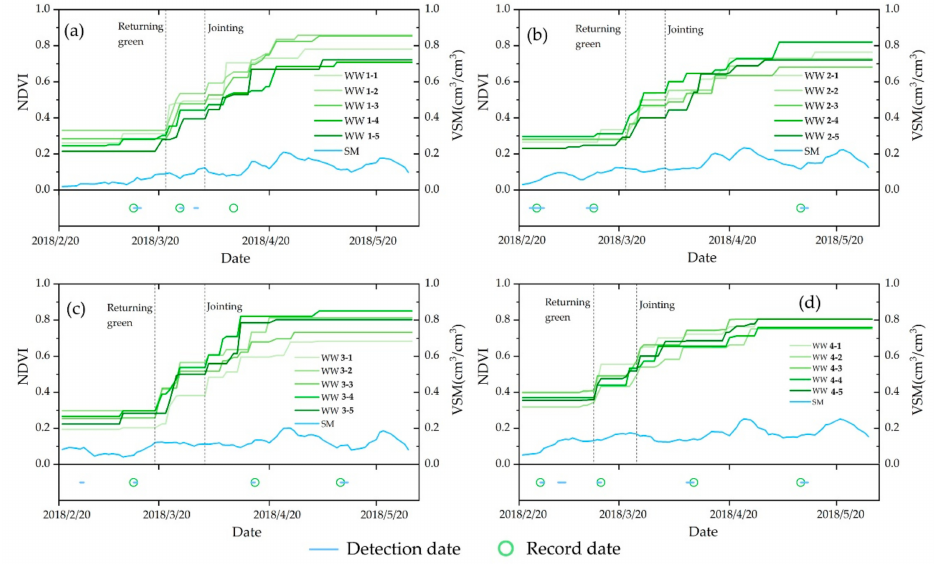
Figure 10. SM, NDVI changes (after upper envelop) and irrigation time for di ff erent SMAP